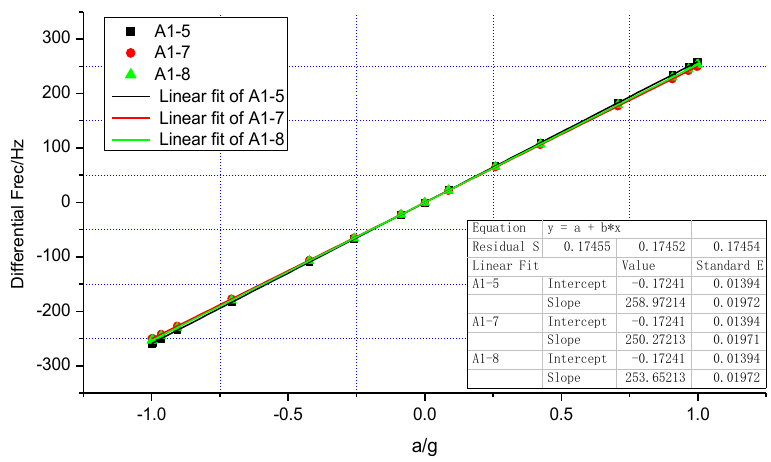
Figure 9. Variation of the differential resonant frequency Δf for three SMRA prototypes between the resonators in the range of ±1 g.